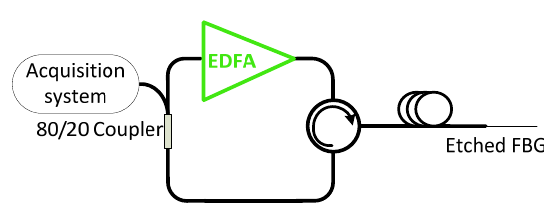
Figure 5. Fiber laser sensor experimental setup.